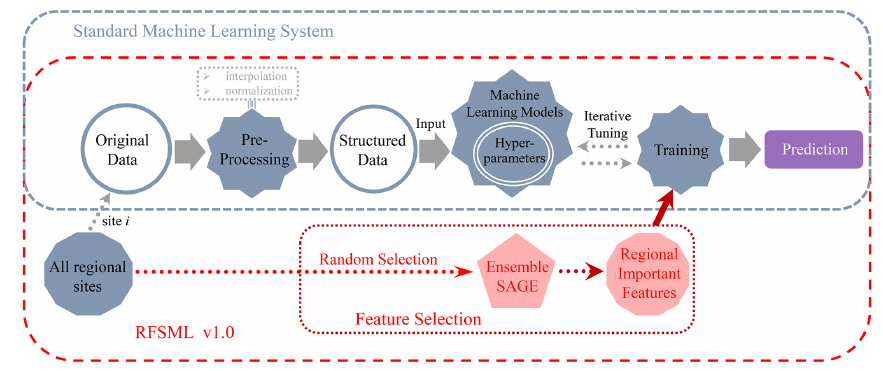
Figure 3. RFSML versus standard machine learning system framework. Table 4. Summary of model’s